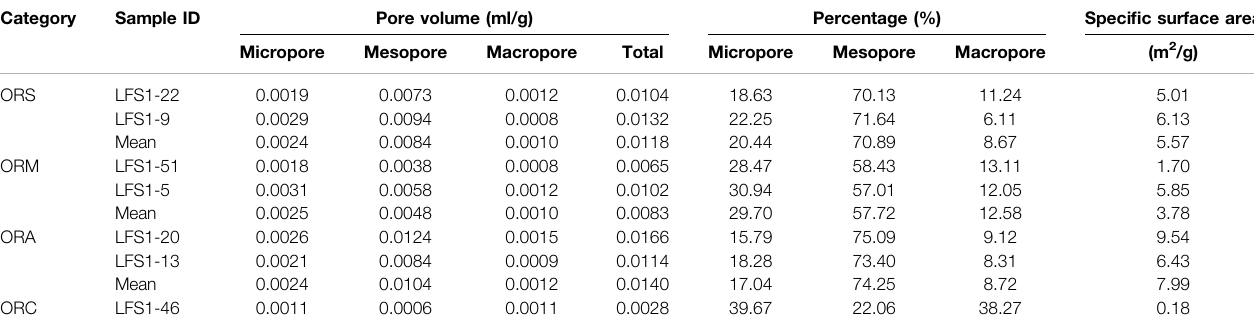
TABLE 4 | Pore volume of all size pores in the shale of different lithofacies types from the Shahezi Formation. Category Sample